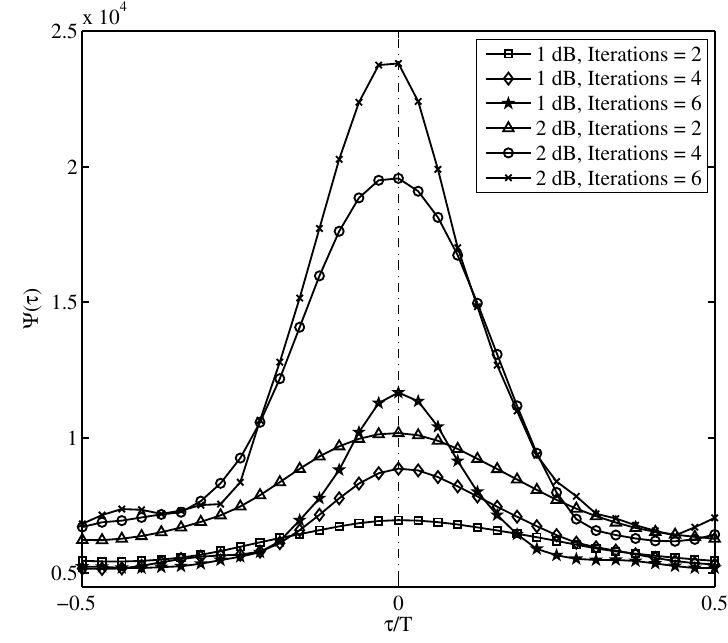
Figure 4. Partial curves of Ψ ( τ ,0 ) to τ with two, four, and six iterations.